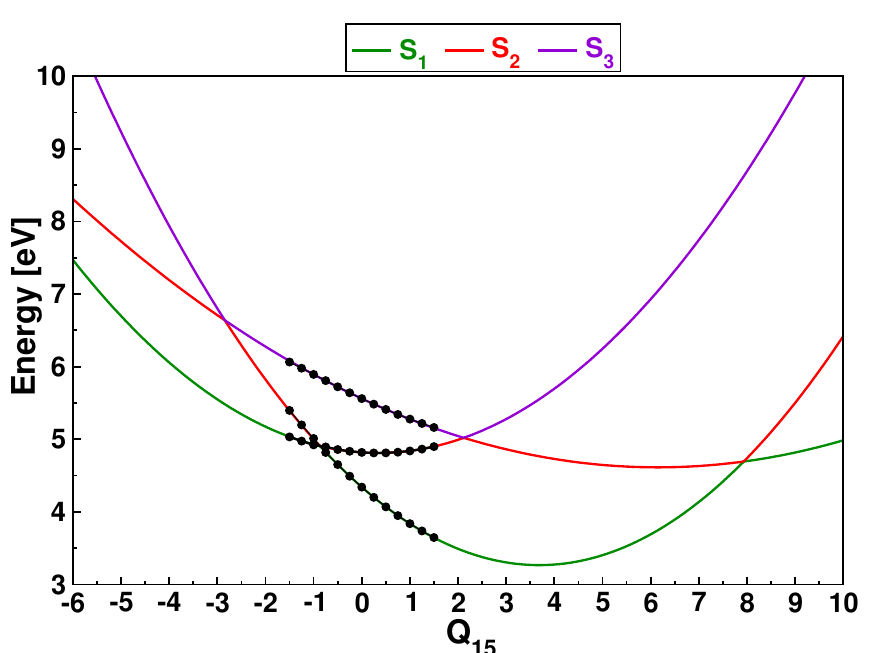
Figure 2. Computed adiabatic potential energy curves of along Q 15 of C 7 H 4 within the QVC approach. The solid circles represent the ab initio points plus ground-state harmonic potential energy.